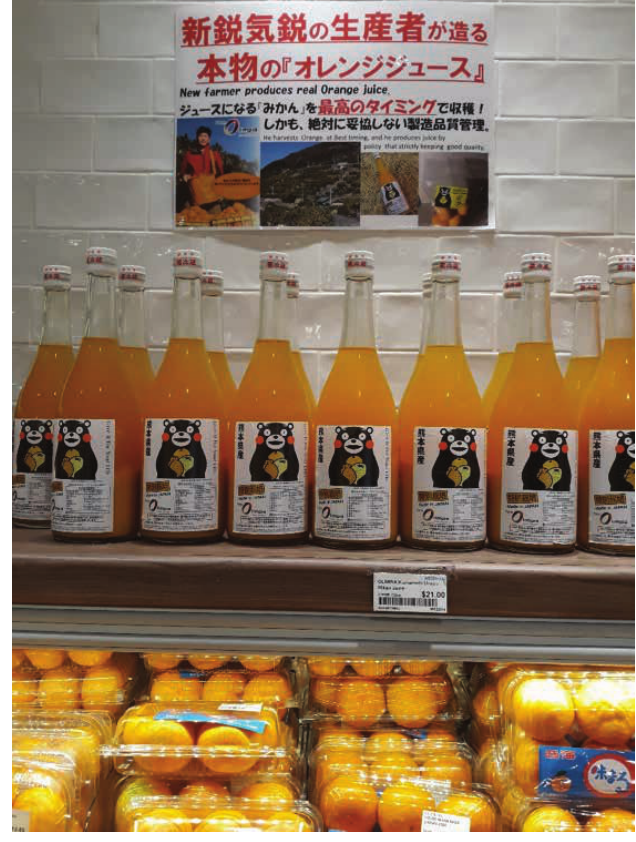
Figure 7: Farm Olympia and Mikan oranges: from field to